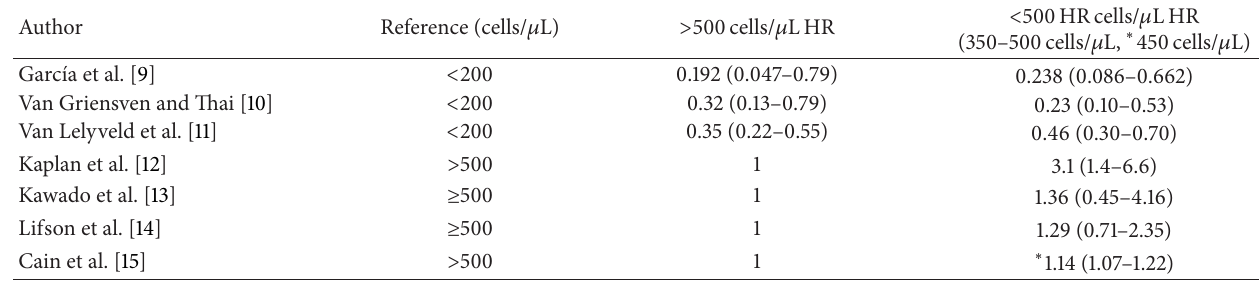
Table 2: Effect measure and referent group of studies reviewed.